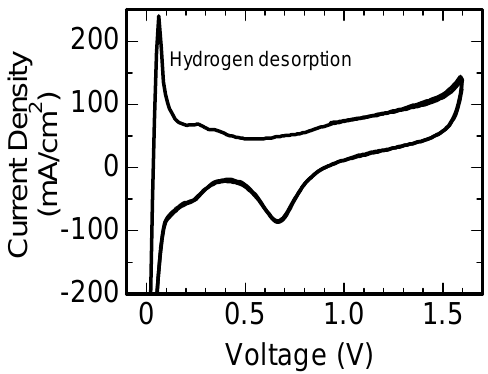
Figure 4. Cyclic voltammogram observed for the fuel cell, which was fabricated with the carbon black after the in ‐ liquid plasma process was carried out for 20 min.